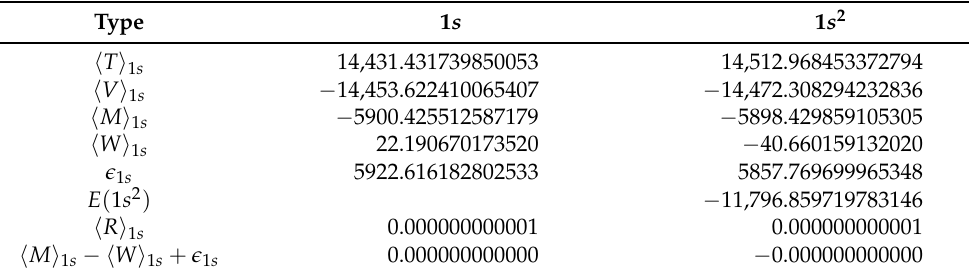
Table 4. Energy contributions (in E h ) to virial theorems for hydrogen-like (1-electron, Fermi nucleus) and heliumlike (2-electron, point nucleus) fermium ( Z = 100, A = 257) ground states. Parameters for the Fermi nuclear charge distribution, ρ ( r ) = ρ 0 / ( 1 + e ( r − b ) / a ) , were r rms = 5.8756 fm, a = 0.523387555 fm, b = 7.170561722 fm. All quantities are for a single 1 s